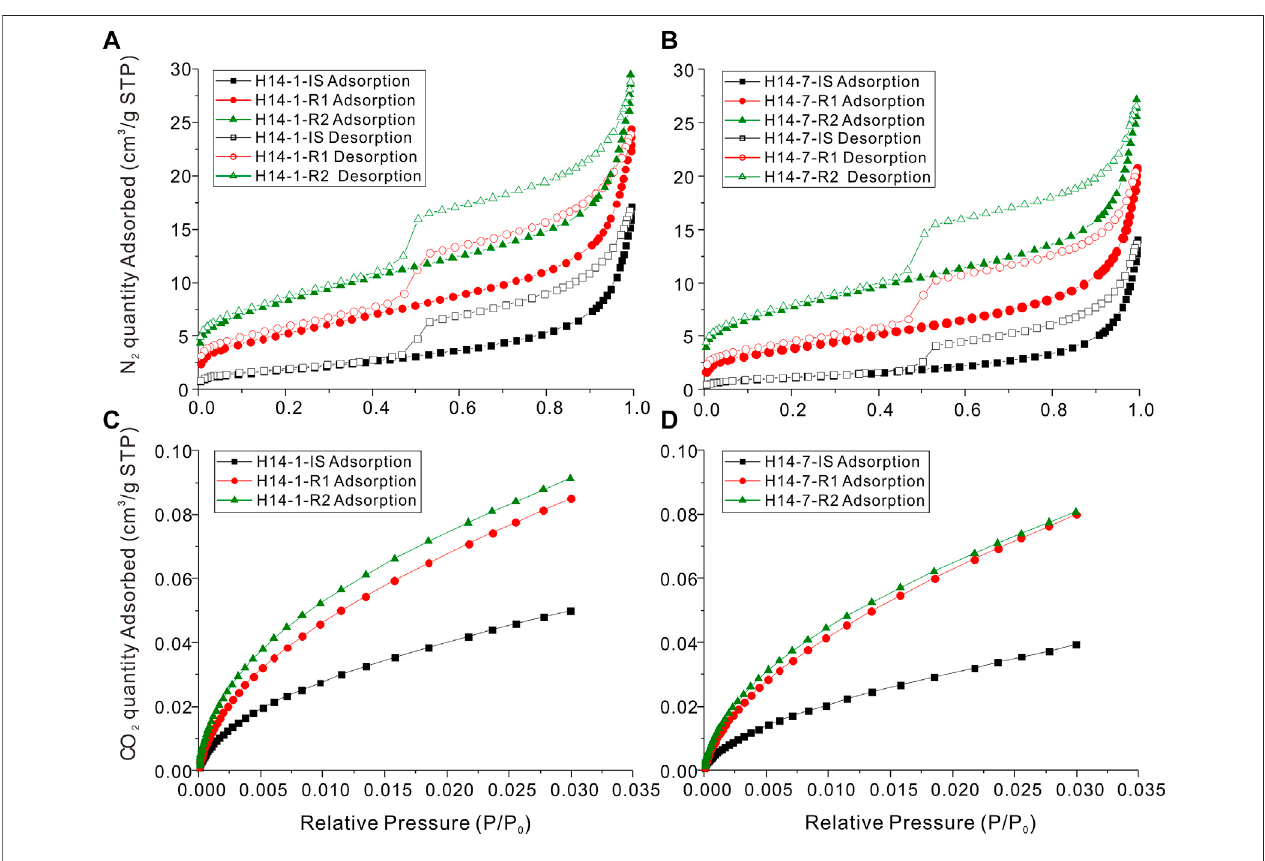
FIGURE 5 | Nitrogen and carbon dioxide gas adsorptions and desorption isotherms.